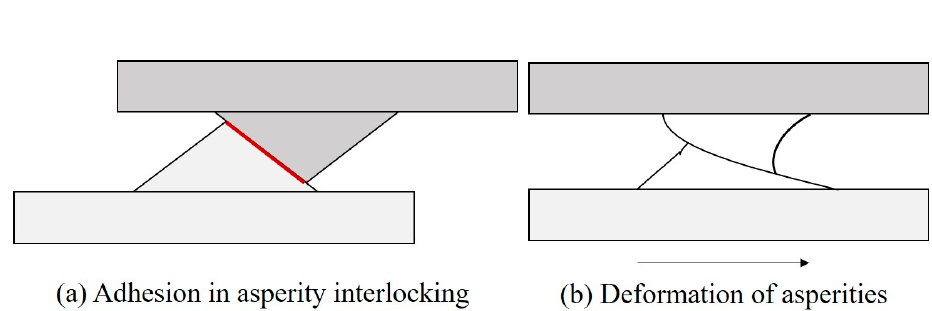
Figure 2. ( a ) Adhesion between interlocked asperities and ( b ) deformation of asperities in the shear direction.